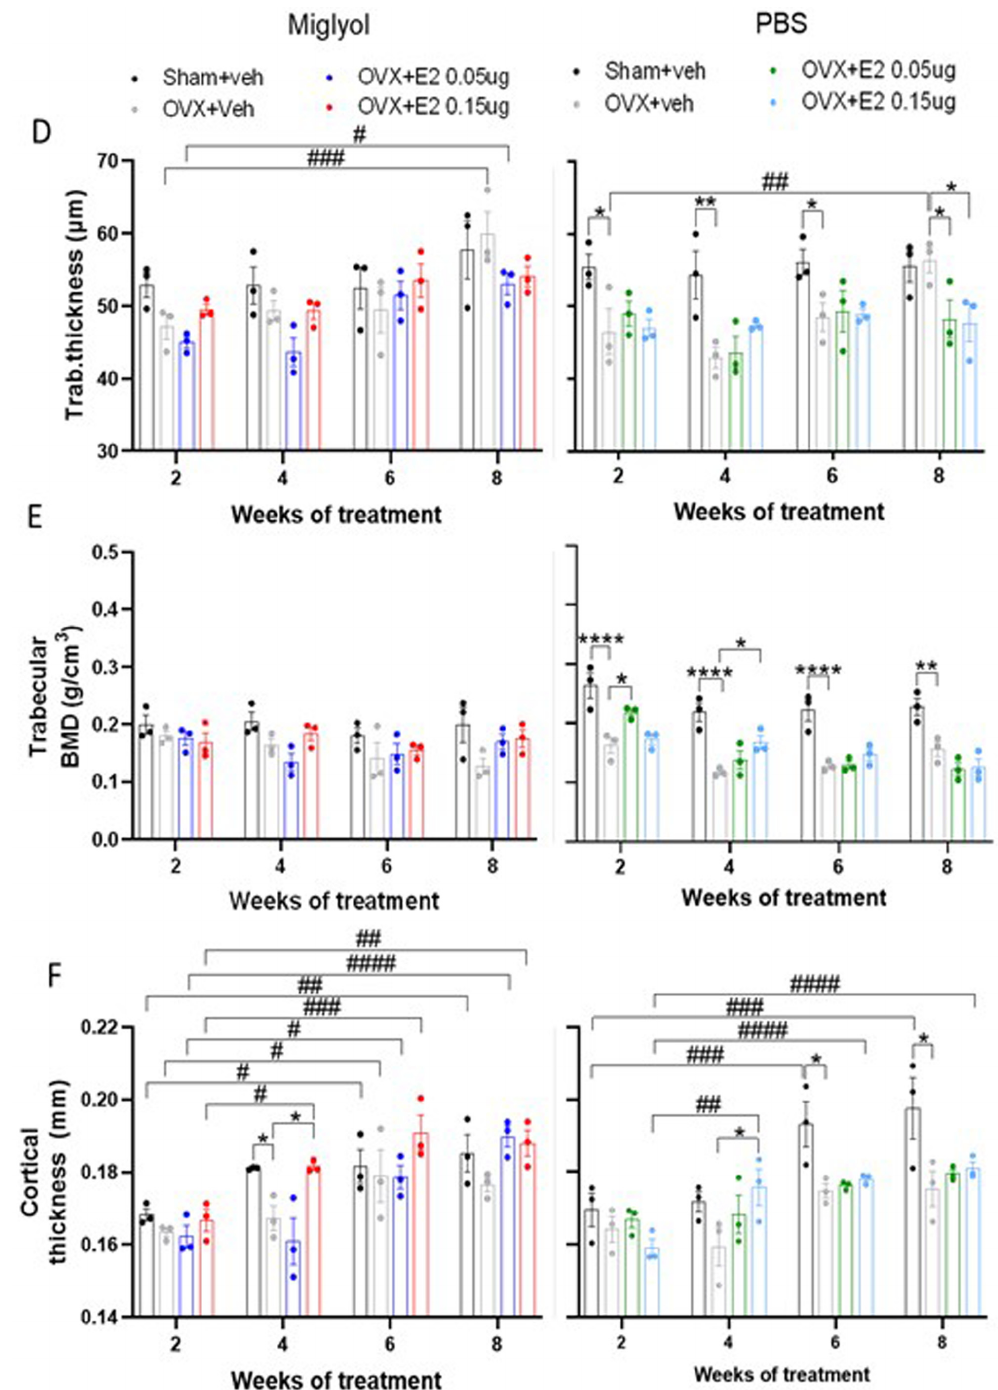
Figure 7. Features of femur analysed by µCT analysis. Mice were subjected to Sham or OVX surgery and treated with s.c. injections of vehicle (miglyol or PBS) or 17β-estradiol (E2; 0.05µg/mouse or 0.15µg/mouse) every 4 days. Experiments were terminated at 2, 4, 6 and 8 weeks after the start of treatments and femurs were dissected. Trabecular and cortical parameters of the femoral bone were determined by micro-computed tomography (µCT) analysis. Representative µCT scan pictures of the trabecular and cortical femur for the experimental groups after eight weeks of treatment ( A ). µCT analyses of bone volume/total volume (BV/TV); B ), trabecular number ( C ), trabecular thickness ( D ), trabecular bone mineral density (BMD; E ), and cortical thickness ( F ) were performed on femur. Data are expressed as mean±SEM; n=3 for each experimental group. * statistical differences between sham+veh vs OVX+veh; or OVX+veh vs the E2 treatment groups; # statistical difference vs week 2 of the same treatment group. *or #, p<0.05; ##, p<0.01; **** or ####, p<0.0001; Two-way ANOVA followed by Dunnet’s post-hoc